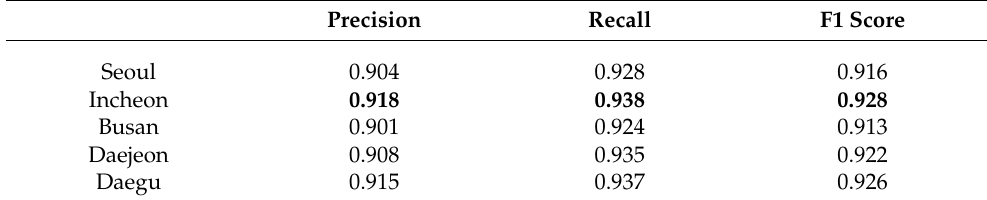
Table 2. Evaluation results.